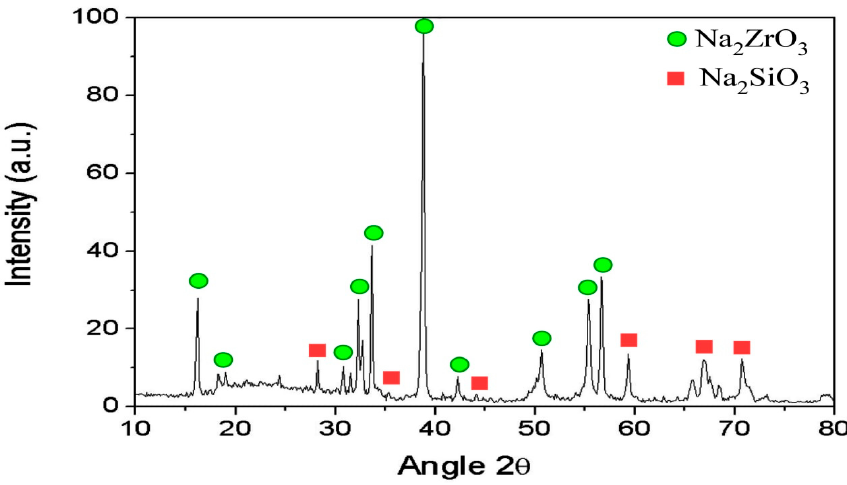
Figure 14. XRD diffractogram of the fused products from ZrSiO 4 . Visually, the transition from brown to dark-grey in the zircon concentration before and after alkali fusion demonstrates the intense caustic environment. The underlying